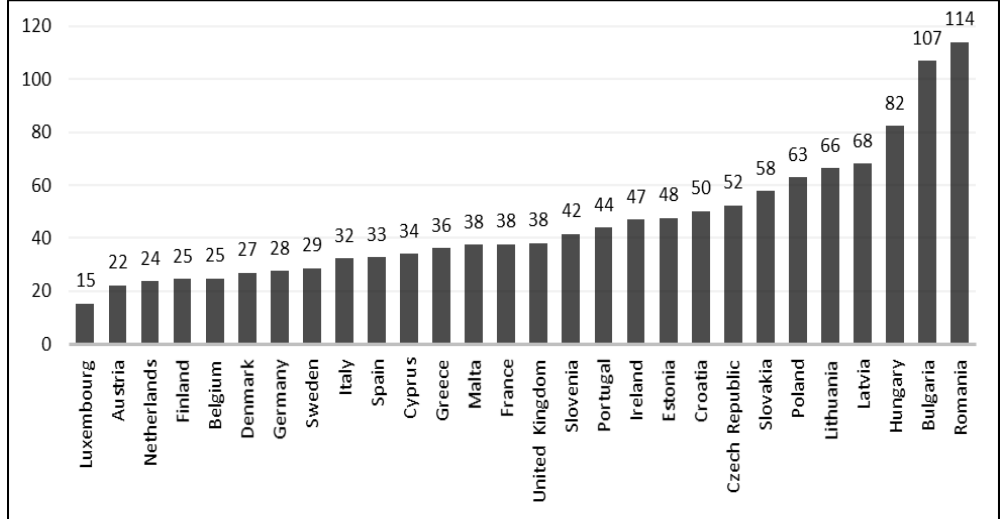
Fig. 2. Work time in minutes to purchase a package of cigarettes (Developed by the author; TAXUD,2016; Eurostat,